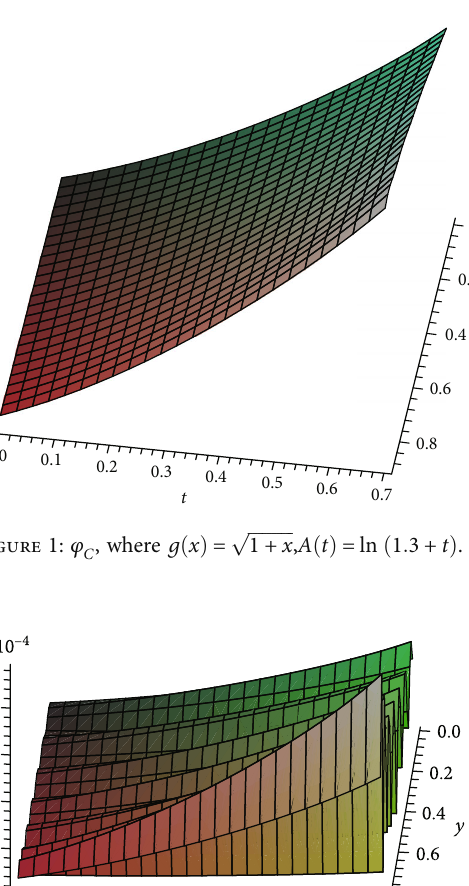
ffiffiffiffiffiffiffiffiffiffi p 1 + x , A ð t Þ = ln ð 1 : 3 + t Þ .